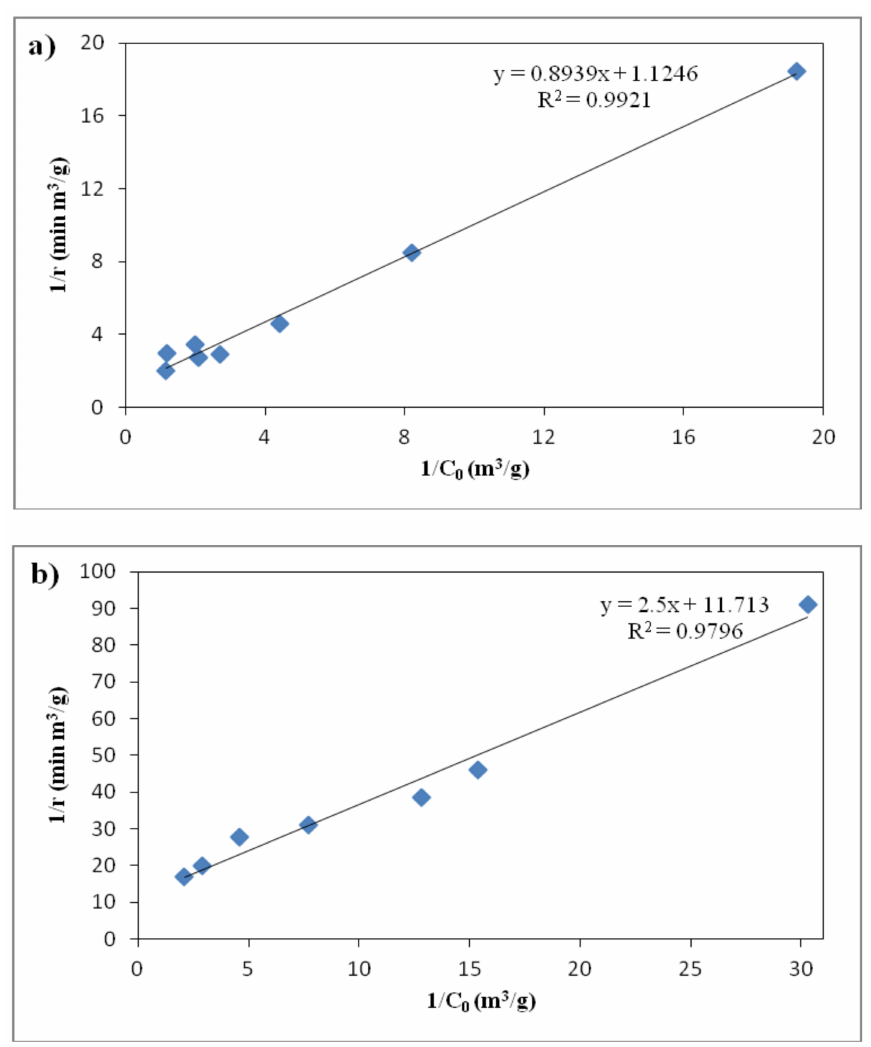
Figure 12. The relationship between the inverse of reaction rates and ethylbenzene initial concentrations using N-doped TiO 2 catalyst under ( a ) UV and ( b ) visible light